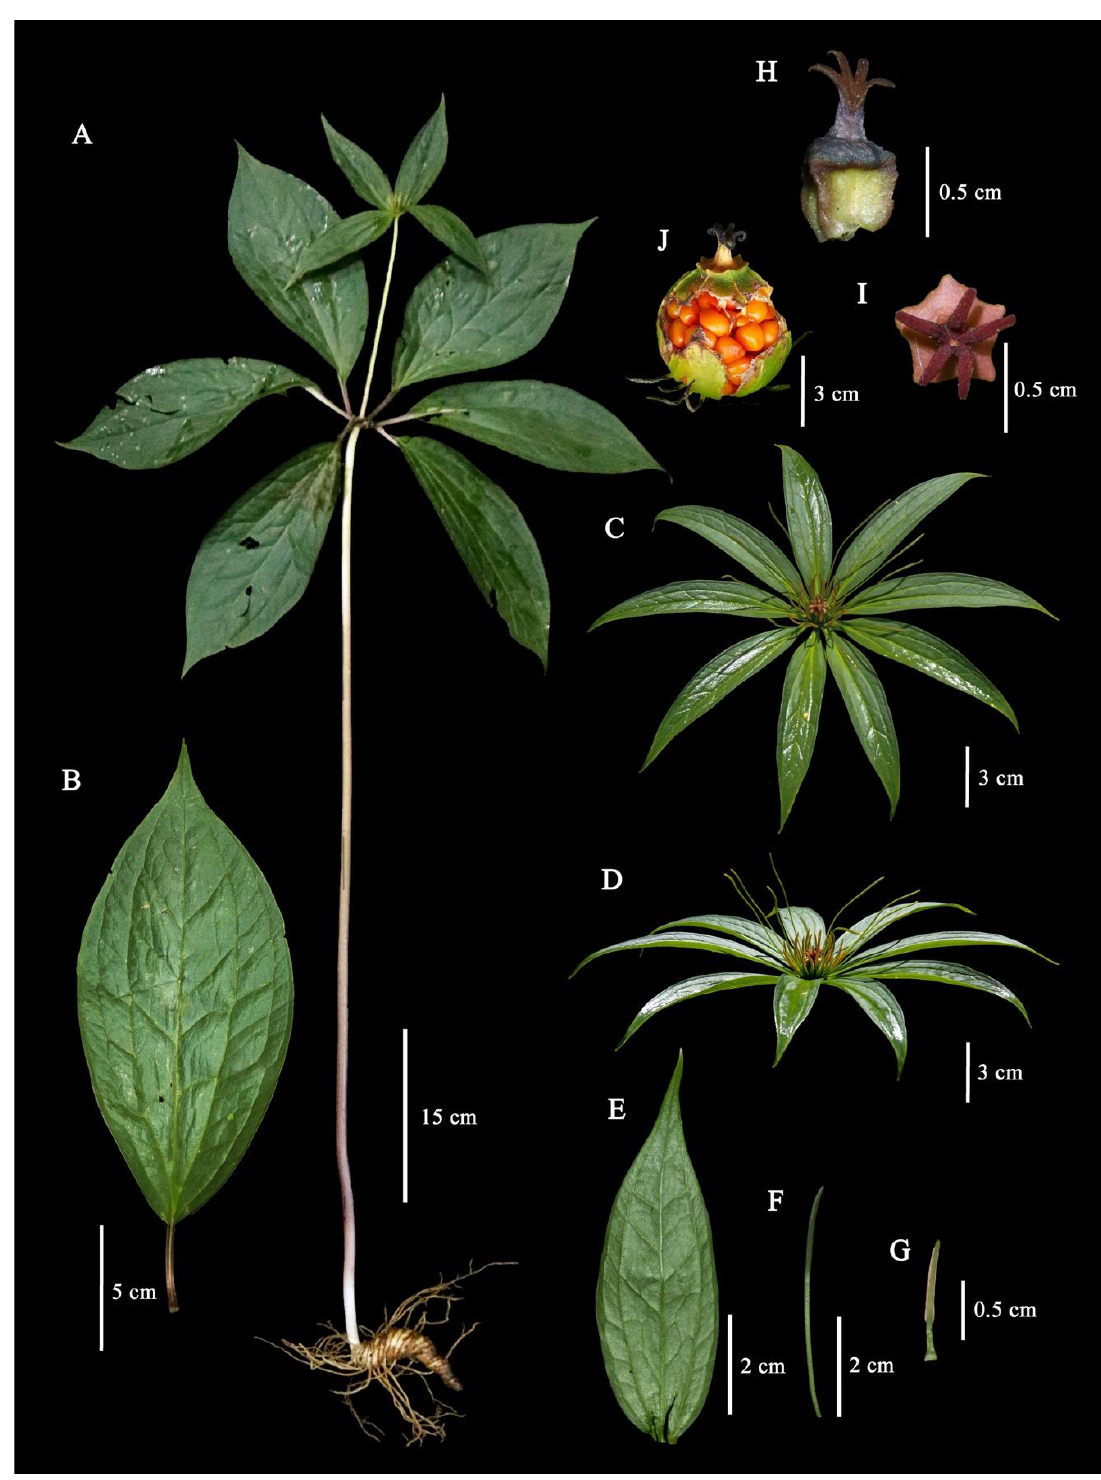
Figure 1. Paris yunnanensis Franch. (A) Habit, (B) Leaf, (C) Flower (front view), (D) Flower (lateral view), (E) Sepal, (F) Petal, (G) Stamen, (H) Pistil (front view), (I) Pistil (lateral view), (J) Fruit.